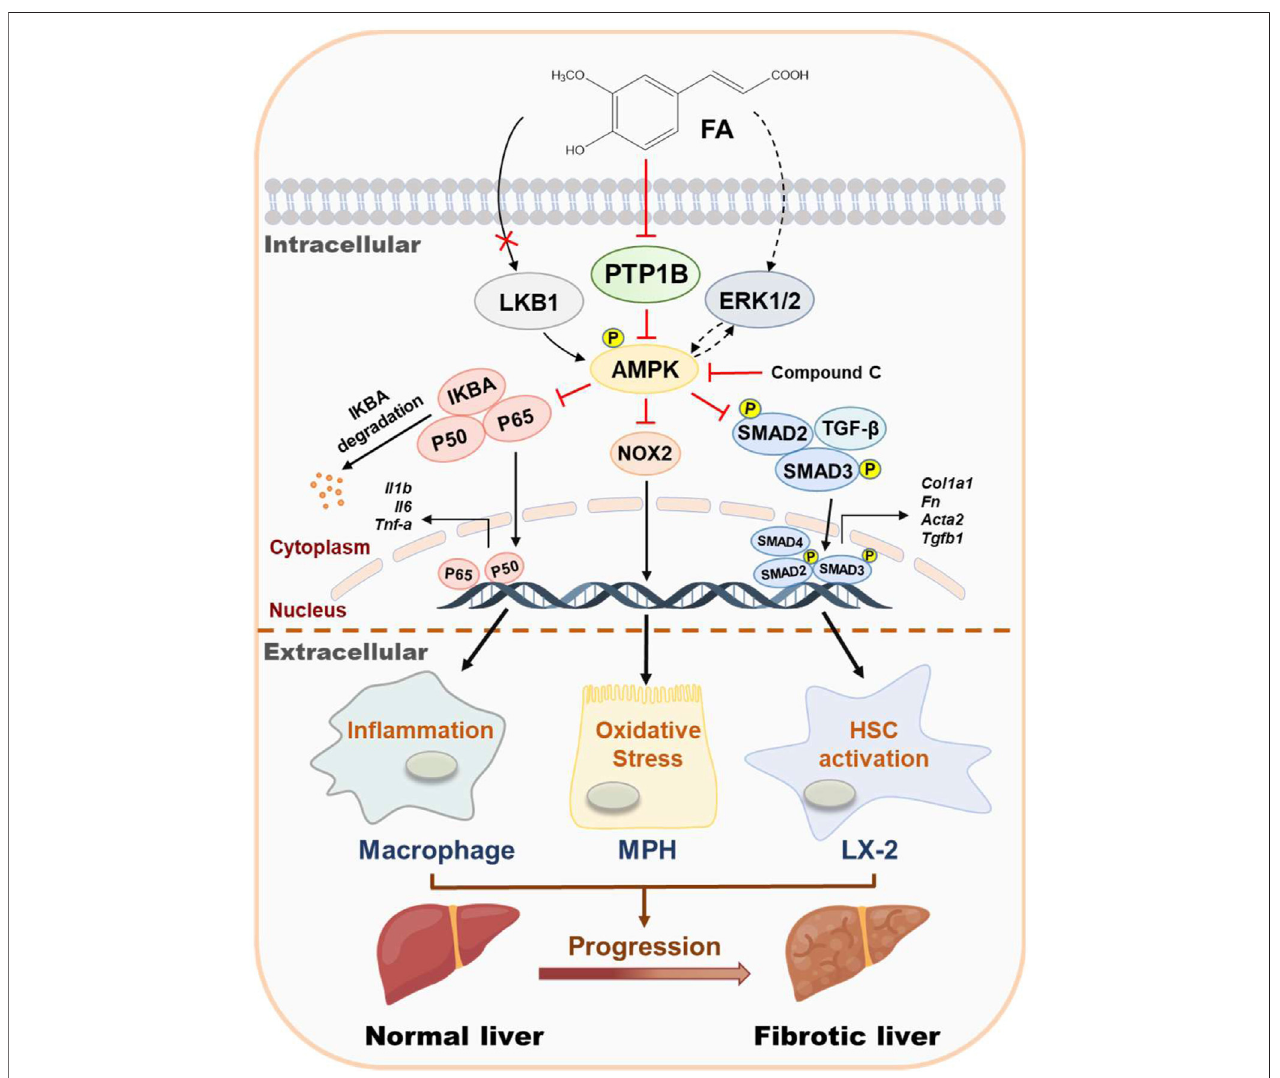
FIGURE 7 | Schematic diagram of the proposed mechanisms underlying the protective effects of FA on oxidative stress, in fl ammation in macrophages and HSC activation during liver fi brosis. FA ameliorated CCl 4 -induced oxidative stress in hepatocytes, relieved LPS-induced in fl ammation in macrophages and alleviated TGF- β -induced fi brotic response in HSCs. The potential mechanism was that FA directly bound to and inhibited the activity of PTP1B, eventually leading to the phosphorylation of AMPK.